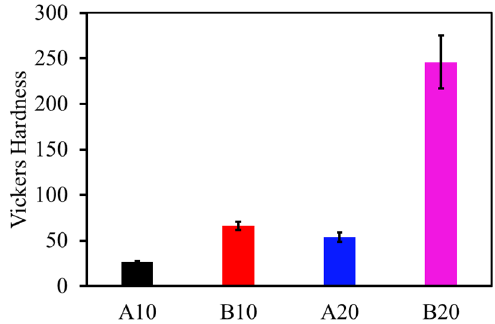
Figure 3. Vickers hardness of the composites.